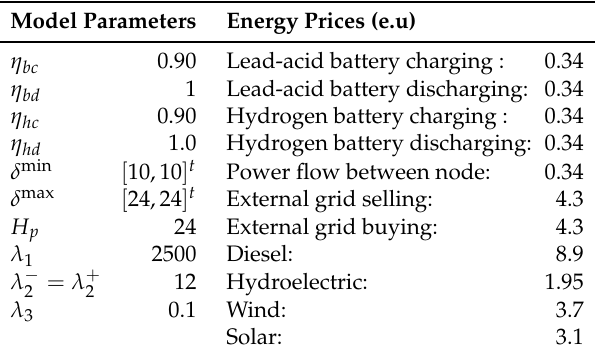
Table 1. System and control parameter values.